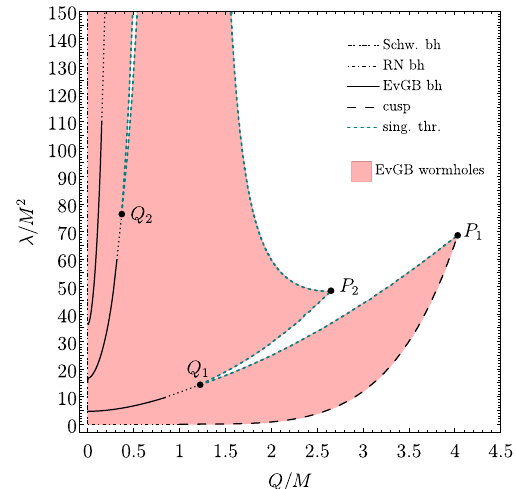
Fig. 10 The same as Fig. 9 for coupling function